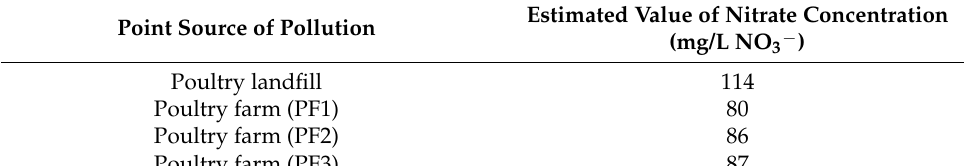
Table 3. Estimated values of nitrate concentration in the area of point sources of pollution.